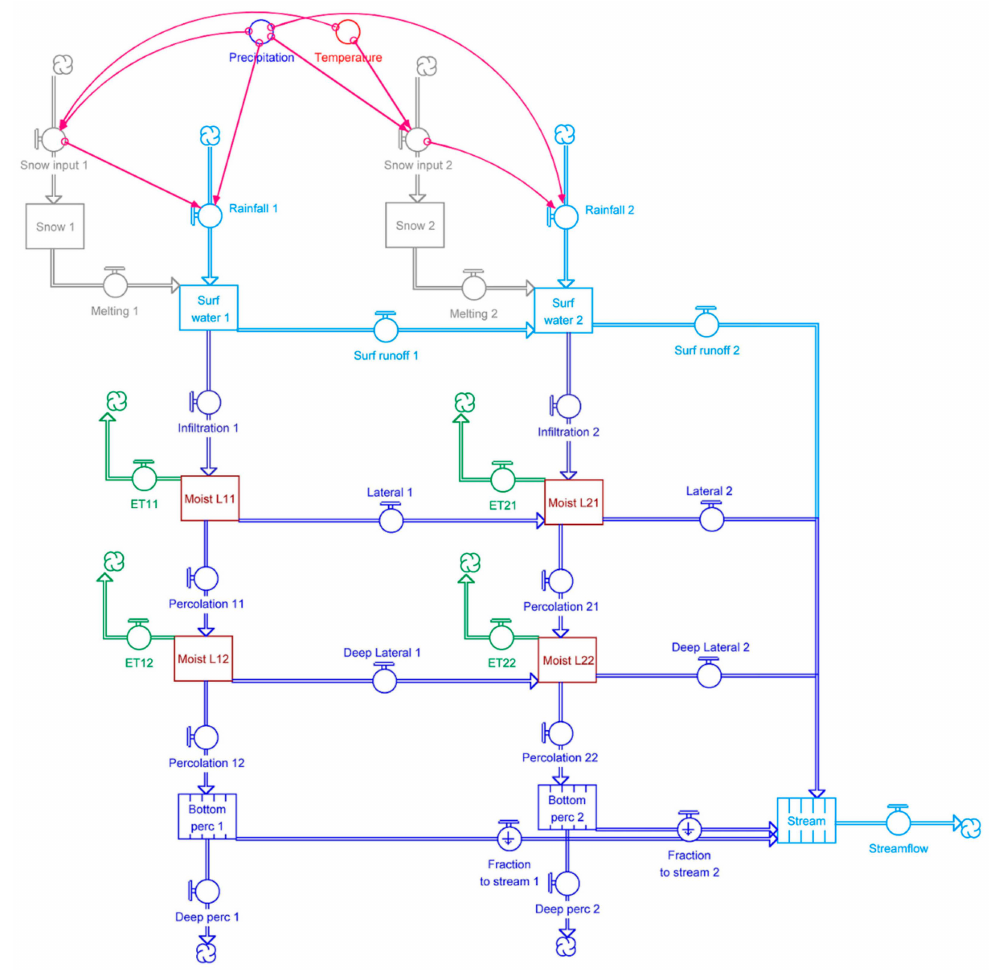
Figure 1. Simplified illustration (considering only two soil columns) of the hydrology as conceptualized in STELLA. The boxes represent water stocks in elements storing water, the blue arrows represent water flows from and to water stocks, the stand-alone circles are converters containing data or equations and the red arrows are connectors indicating which factors are regulating the flows. The striped boxes represent conveyors that transfer water after a specified number of time